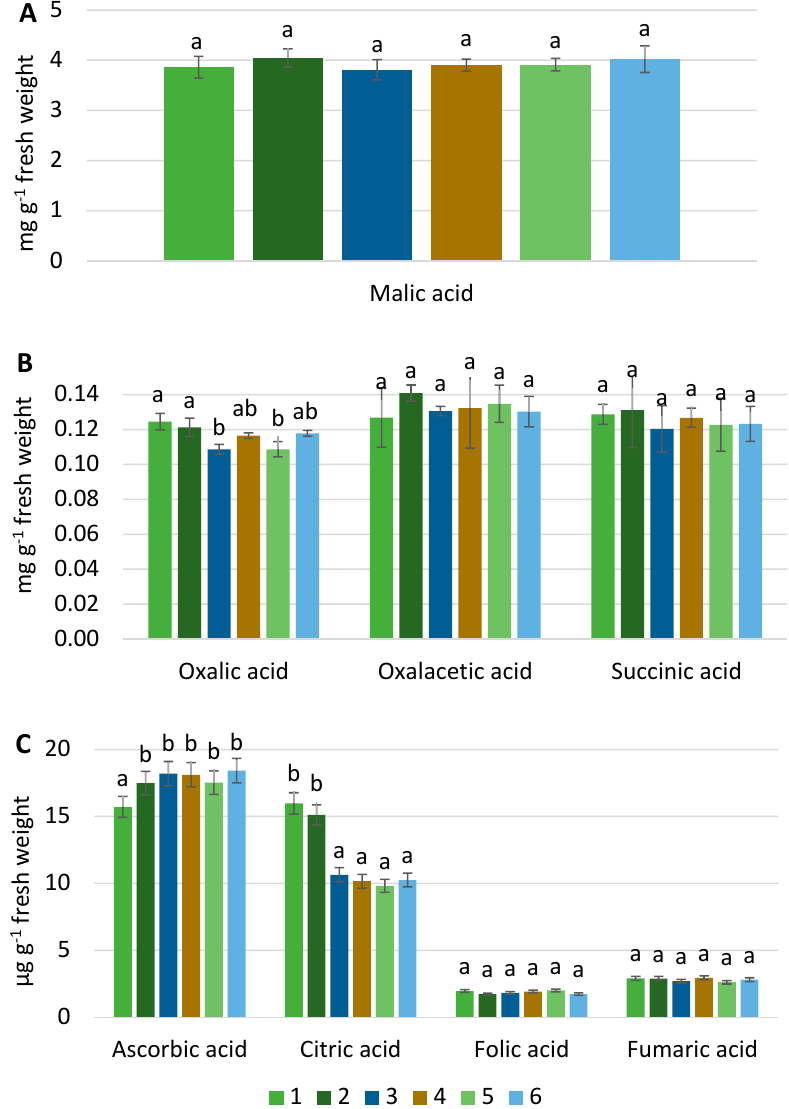
Figure 3. Influence of agrotechnological tools on organic acids ( A ), ( B ), ( C ) in cv. Rubin apples on harvest time (commercial ripening) in average of three years. 1. Each year hand pruning forming slender spindle (control); 2. Mechanical pruning (each year); 3. Trunk incision using chain saw + mechanical pruning (each year); 4. Mechanical pruning (each year) + spraying with calcium-prohexadione; 5. Mechanical pruning + hand pruning + summer pruning; 6. Mechanical pruning one side, changing sides annually. Averages followed by different letter within the same compound indicate significant differences according to the Duncan’s least significant difference test ( p < 0.05). Error bars show standard deviation.